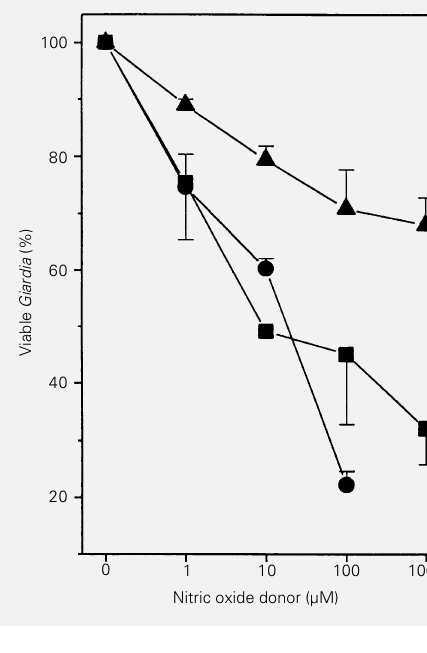
Figure 3 - Enhancement of the Giardia trophozoite-killing effects of SIN-1 by superoxide dismu- tase. Trophozoites were incu- bated with increasing concentra- tions of SIN-1 in the absence (open bars) or in the presence (shaded bars) of SOD (300 U/ml) for 2 h at 37 o C. Results are re- ported as means – SD of tripli- cates. *P<0.05 when compared to groups without SOD (analysis of variance followed by the Bonferroni t -test). The same re- sults were obtained in two ex-